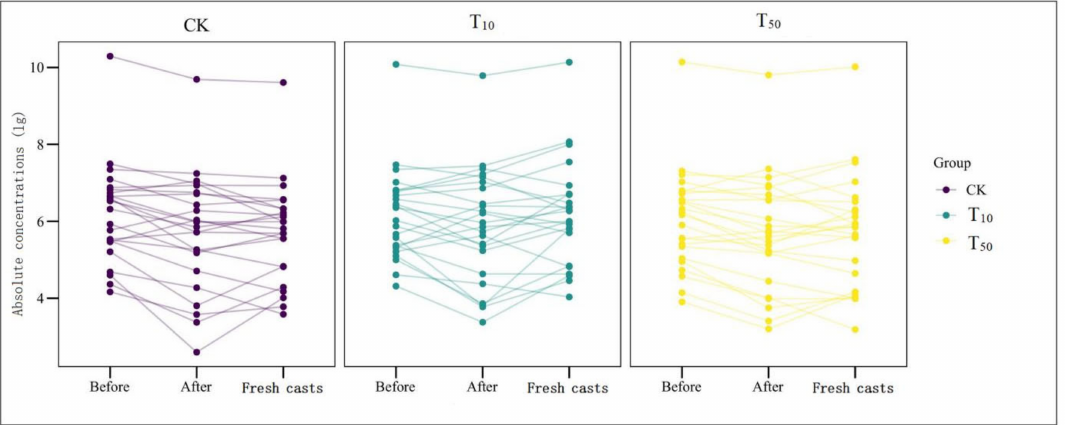
Figure 5. Changes in absolute concentrations of ARGs before and after vermicomposting in different treatment groups: CK, earthworm feeding on cow dung without arsenic addition; T 10 , earthworm feeding on cow dung with 10 mg/kg arsenic; T 50 , 50 mg/kg arsenic, after digestion for 14 days.